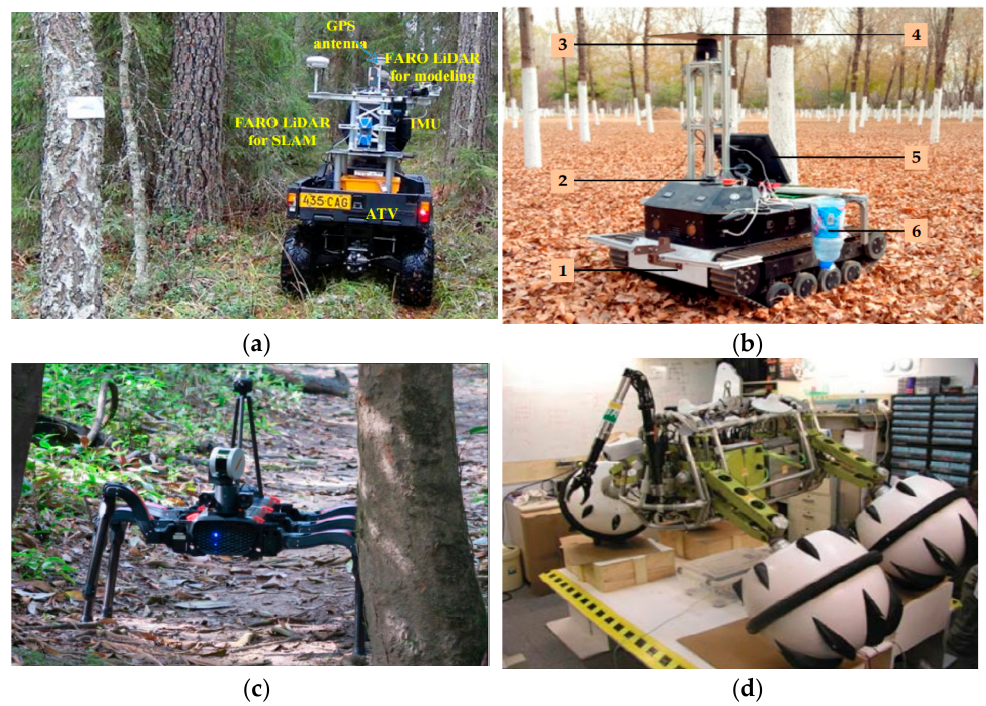
Figure 2. Di ff erent types of UGVs with ( a ) wheels (Figure from[73]) ( b ) tracks (Figure from[74]) ( c ) Figure 2. Different types of UGVs with ( a ) wheels (Figure from [73]) ( b ) tracks (Figure from [74]) legs (Figure from[75]) ( d ) arm robot (Figure from[76]). ( c ) legs (Figure from [75]) ( d ) arm robot (Figure from [76]).